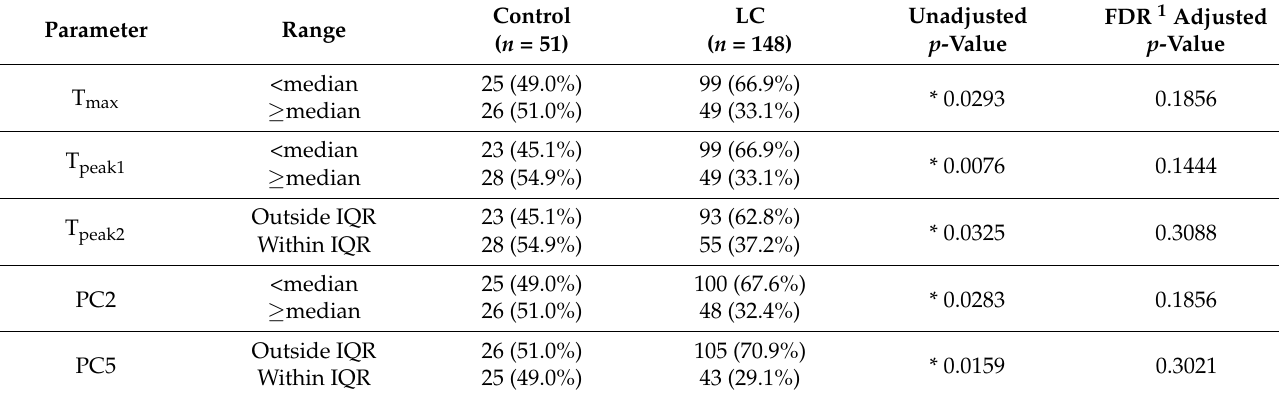
Table 2. Selected associations between summary metrics/PCs and the clinical group. Summary metrics/PCs were dichot- omized based on either the median value or interquartile range (IQR) calculated for control subjects. Parameter